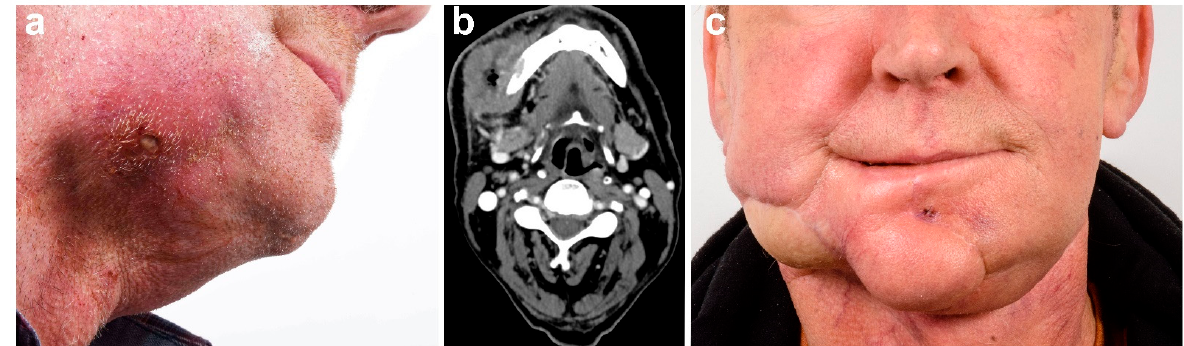
Figure 4. Male patient with primary squamous cell carcinoma of the right-sided mandible with infiltration of the facial skin. ( a ) Tumor infiltration of the right cheek. ( b ) CT scan depicting the tumor of the right-sided mandible with infiltration of the facial skin. ( c ) Full-frontal image of the postoperative situation after full-thickness tumor resection and reconstruction with ALT flap.